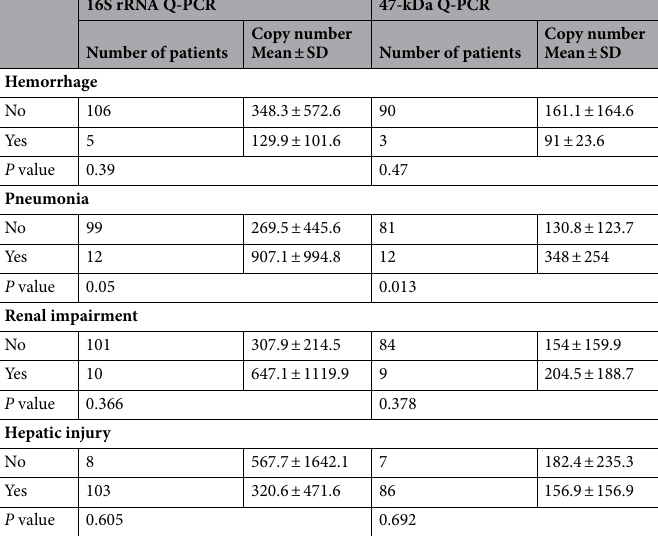
Table 3. Mean copy number detected by 16S rRNA Q-PCR and 47-kDa Q-PCR according to complications. ‘Number of patients’ indicates the number of positive patients detected by each PCR method for patients without prior antibiotics treatment. SD standard